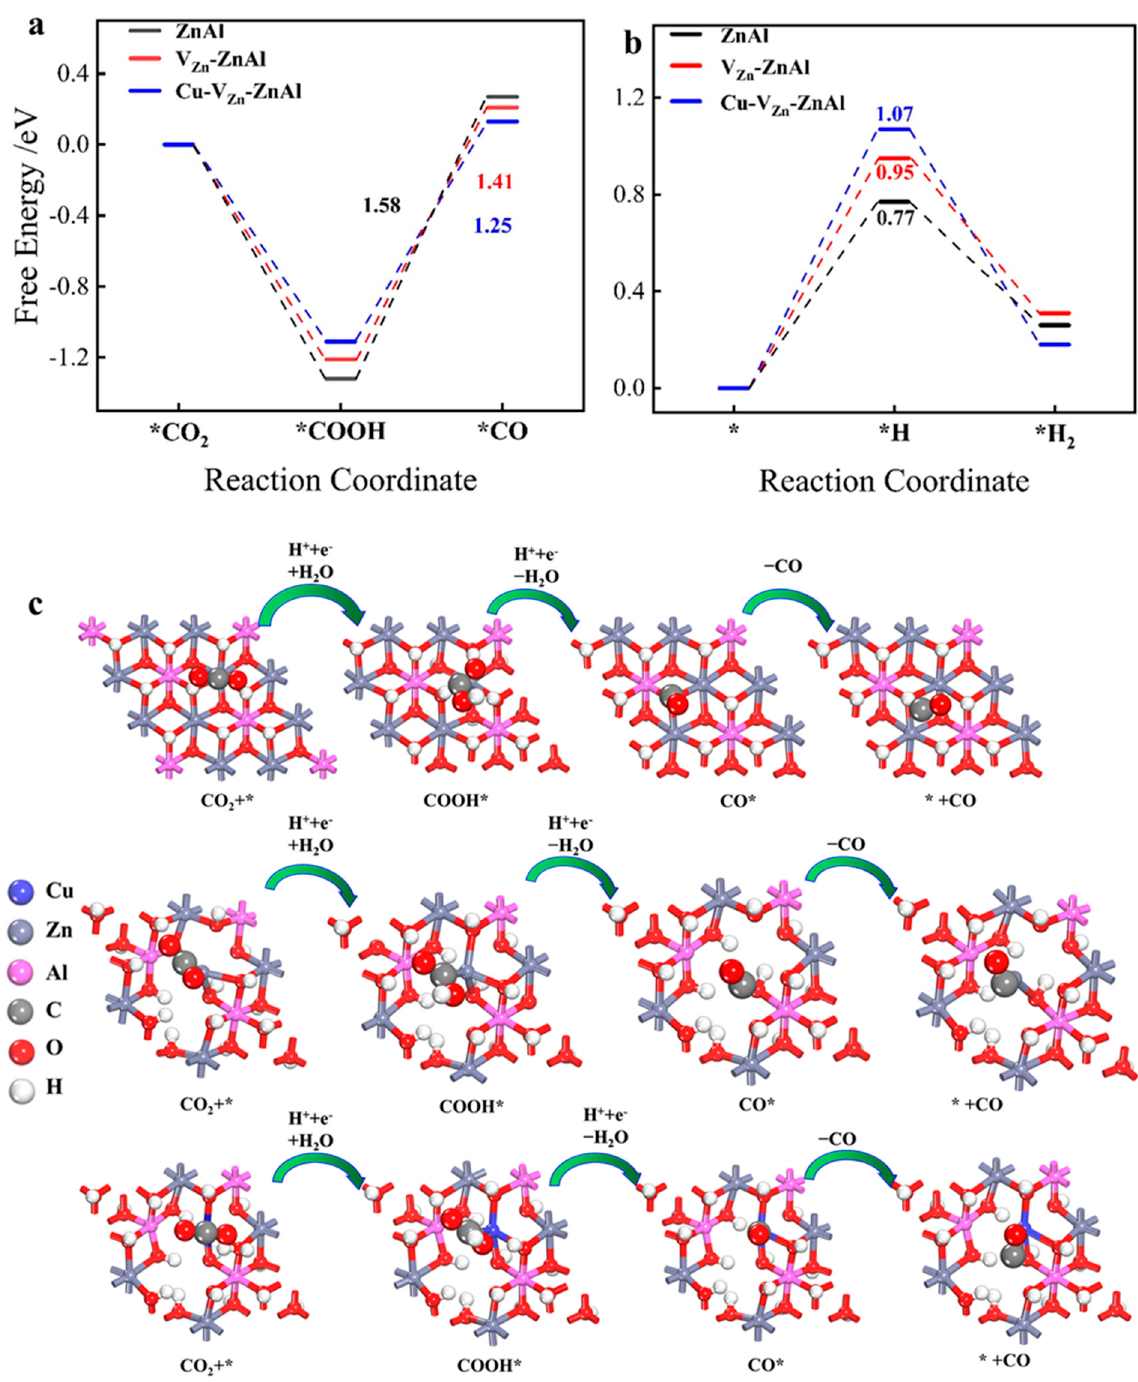
Figure 8 . The Gibbs free energy diagrams of ( a ) CO 2 reduction, ( b ) H 2 evolution, and ( c ) intermedi- ates during CO 2 reduction to CO over ZnAl-LDH, V Zn -ZnAl-LDH, and Cu-V Zn